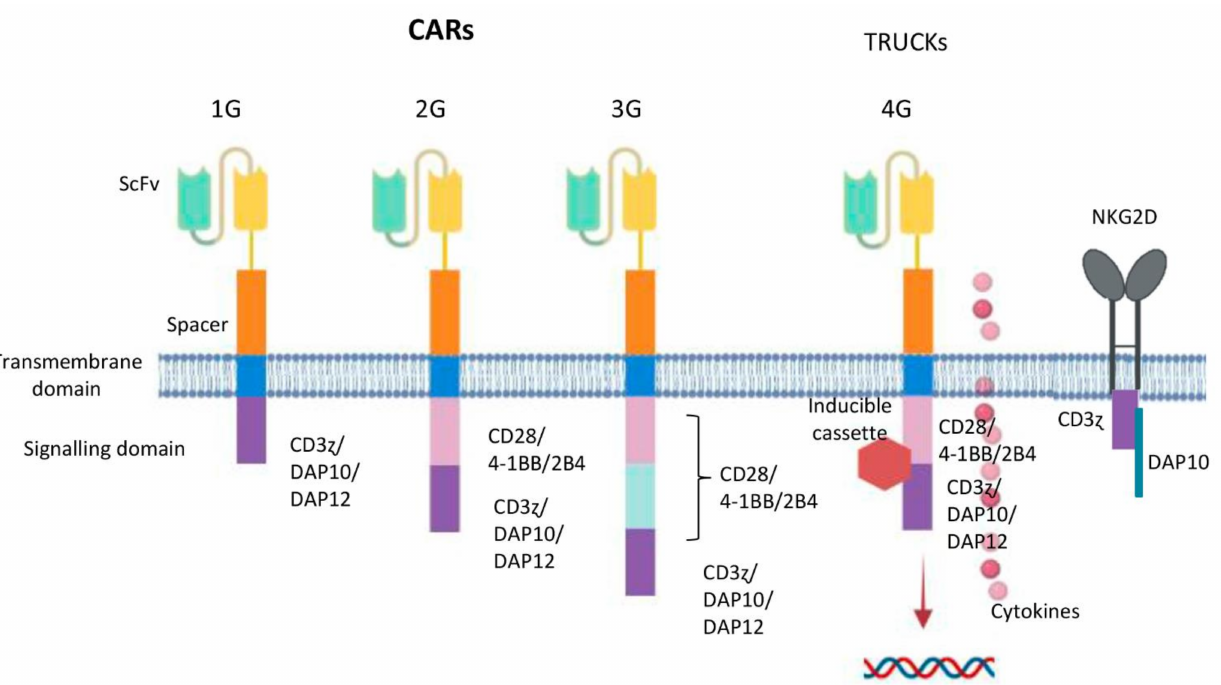
Figure 3. Potential design of CAR generation according to NK cell intracellular motifs and functions. From left to right: First generation CARs (1G) have an intracellular tyrosine-based activation motif, such as a CD3 ζ chain, DAP10 or DAP12. Second generation CARs (2G) include a co-stimulatory domain (CD28, 4-1BB or 2B4) in tandem with CD3 ζ or DAP10 or DAP12. Third generation CARs (3G) contain two co-stimulatory elements (CD28, 4-1BB or 2B4) in tandem with CD3 ζ or DAP10 or DAP12. Fourth generation CARs (4G or TRUCKs) are additionally modified with an inducible or constitutive expression cassette for a transgenic protein. NKG2D ectodomain with DAP10 and CD3 ζ cytoplasmic signalling